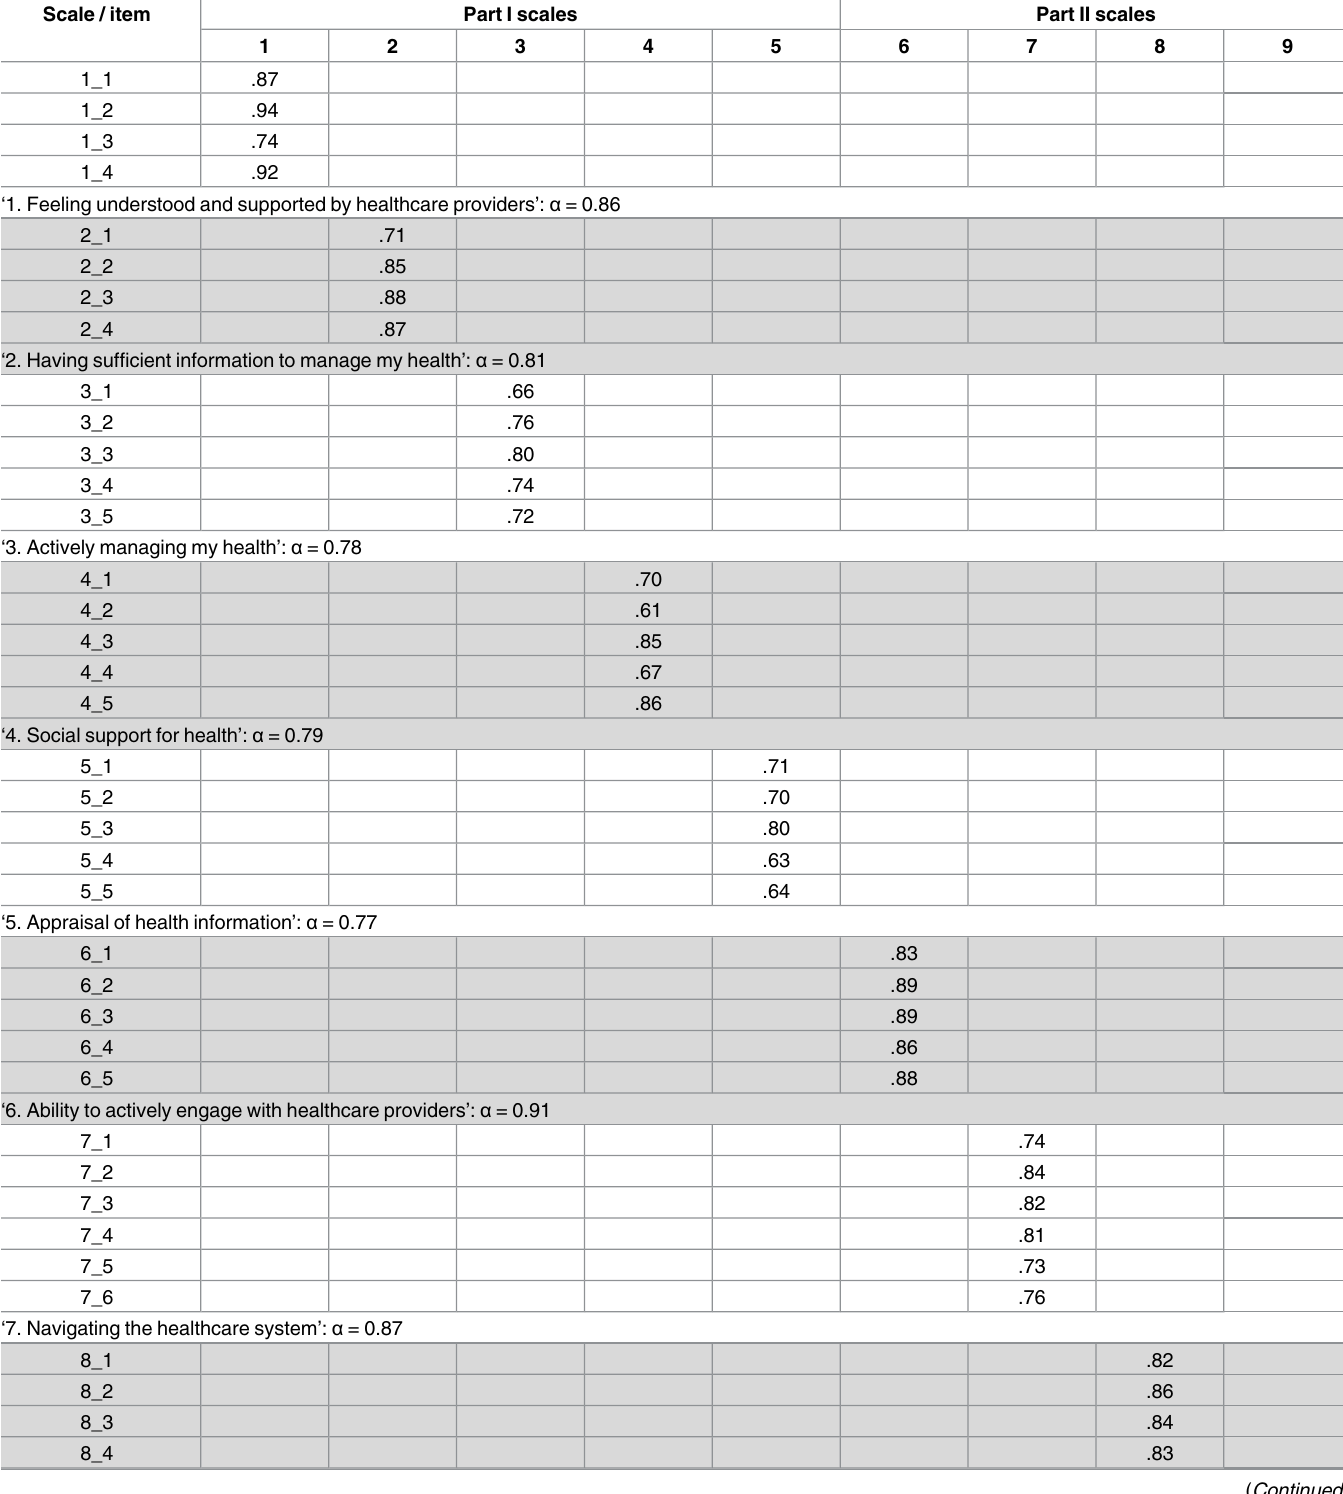
Table 2. Factor loadings of the nine-factor model of the Health Literacy Questionnaire in German (HLQ-G); Cronbach’s Alpha ( α ) by individual HLQ scale. Scale /